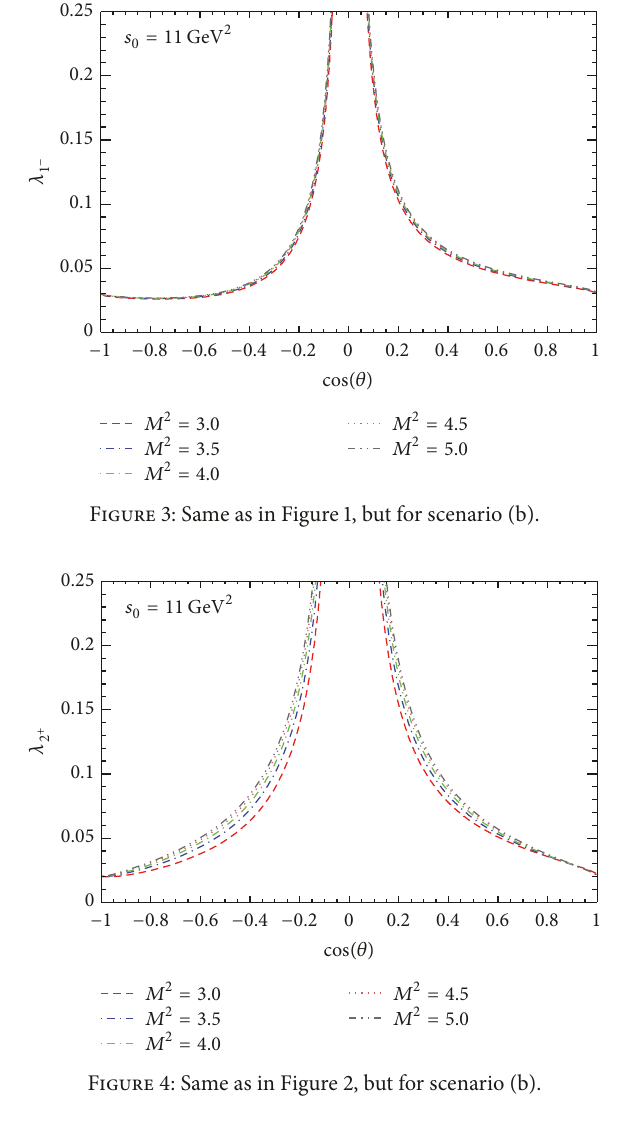
working regions which are determined from mass sum